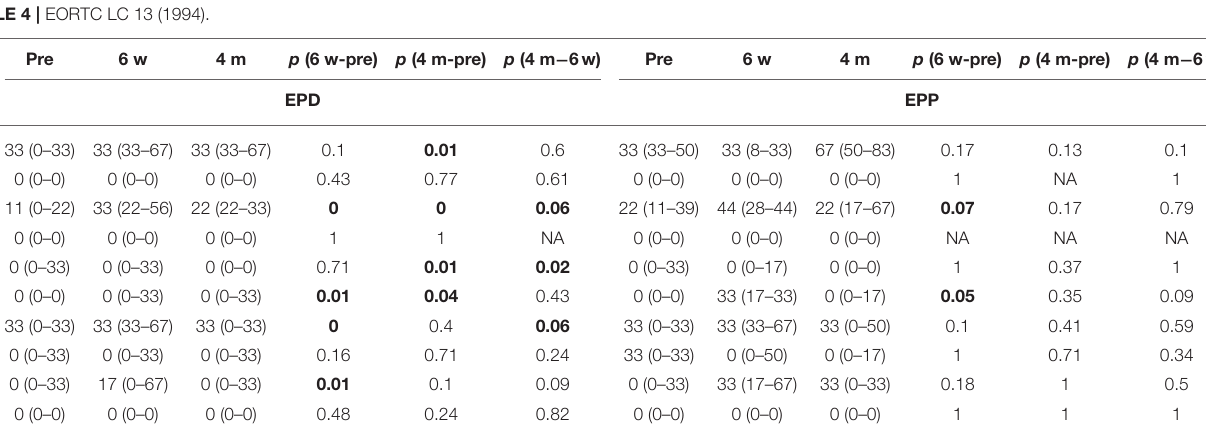
TABLE 4 | EORTC LC 13